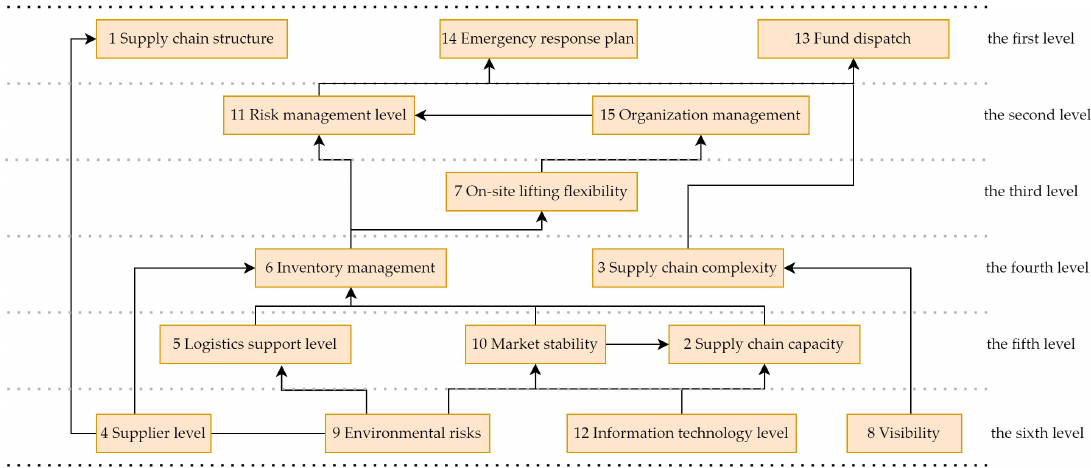
Figure 3. Multi-level hierarchical structure diagram.